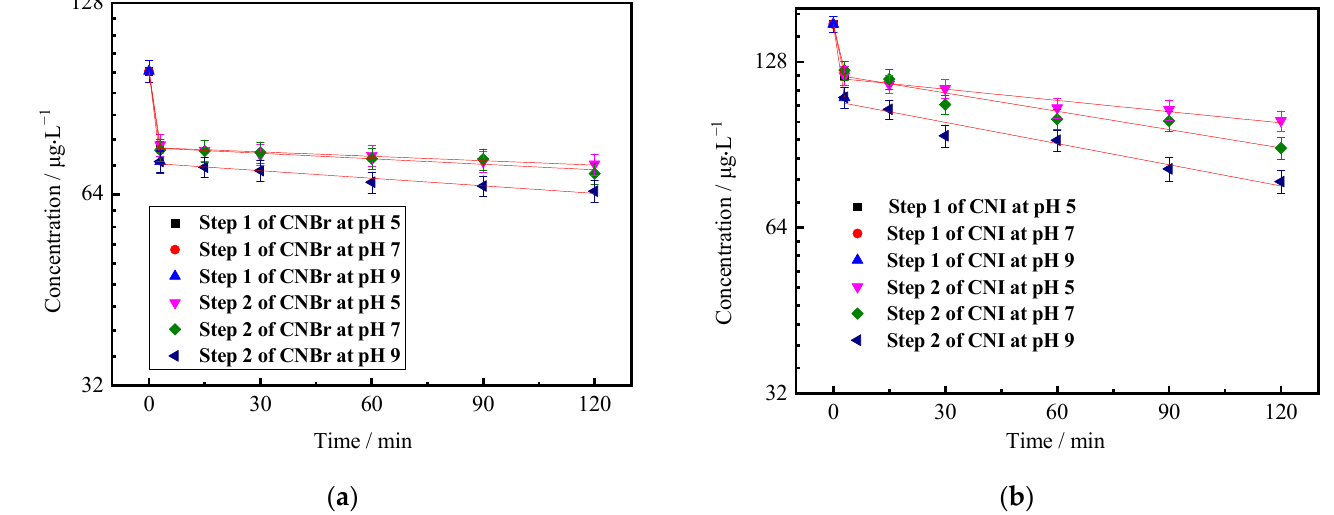
Figure 9. Stability of CNBr ( a ) and CNI ( b ) in the presence of sulfite ([CNBr] 0 = 100 μg/L, [CNI] 0 = 150 μg/L, [SO 32− ] 0 = 3 μmol/L).